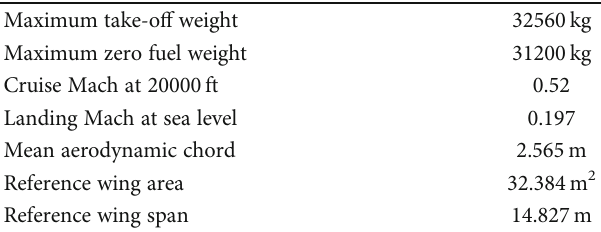
Table 1: Reference aircraft